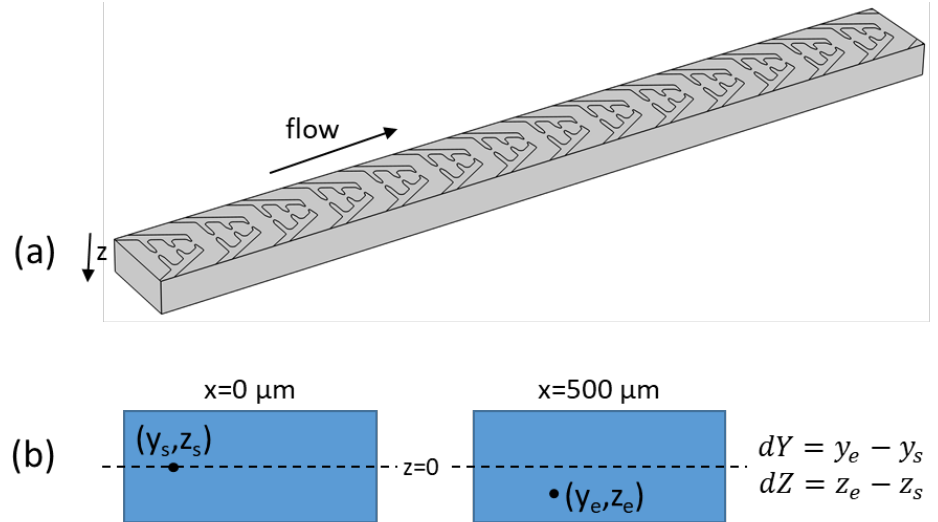
Figure 2. ( a ) The 500 µm long channel with electrodes on the bottom side used for the simulations. ( b ) The starting and ending position of each particle starting at a certain (y,z) point at x = 0 µm is noted after the particle has moved in the channel to x = 500 µm. The displacement along the height and width is used to evaluate how well each electrode design is performing in terms of particle focusing.